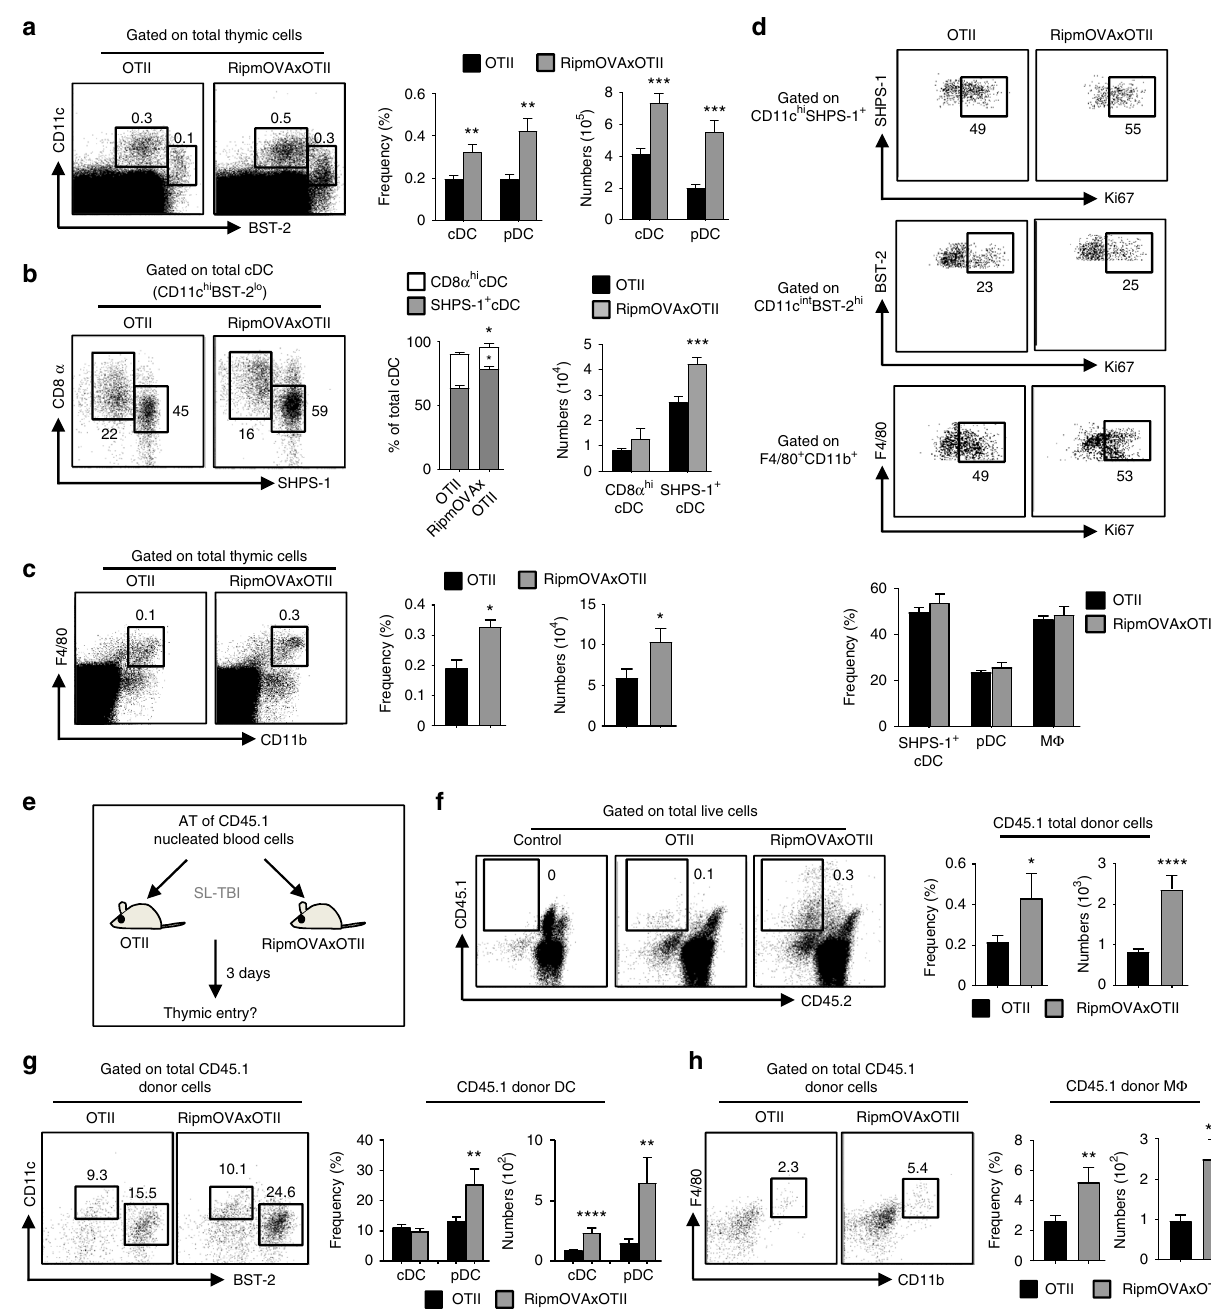
Fig. 1 Ag-speci fi c interactions between mTECs and CD4 + T cells increase the thymic entry of circulating DCs and macrophages. a – c Flow cytometry pro fi les, frequencies and numbers of cDCs (CD11c hi BST-2 lo ), pDCs (CD11c int BST-2 hi ) ( a ), resident cDCs (CD8 α hi SHPS-1 − ), migratory cDCs (CD8 α lo SHPS- 1 + ) ( b ) and macrophages (F4/80 + CD11b + ) ( c ) in the thymus from OTII- Rag2 − / − and RipmOVAxOTII- Rag2 − / − mice. Data are representative of three independent experiments ( n = 3 mice per group and per experiment). d Flow cytometry pro fi les and frequencies of proliferating Ki-67 + thymic DC subsets and macrophages. Data are representative of two independent experiments ( n = 3 mice per group and per experiment). e Experimental setup: nucleated blood cells from CD45.1 WT congenic mice were adoptively transferred into sublethally irradiated CD45.2 OTII- Rag2 − / − and RipmOVAxOTII- Rag2 − / − recipients. Three days after i.v . adoptive transfer (AT), the thymic entry of DCs and macrophages of CD45.1 donor origin was analysed. SL-TBI: sublethal total body irradiation. f – h Flow cytometry pro fi les, frequencies and numbers of CD45.1 total donor cells ( f ) as well as cDCs, pDCs ( g ) and macrophages ( h ) of CD45.1 donor origin in the thymus from OTII- Rag2 − / − and RipmOVAxOTII- Rag2 − / − recipients. Control: non-injected irradiated OTII- Rag2 − / − mice. Data are representative of three independent experiments ( n = 3 – 4 mice per group and per experiment). d , h M Φ : macrophage. Error bars show mean ± SEM, * p < 0.05, ** p < 0.01, *** p < 0.001, **** p < 0.0001 using unpaired Student ’ s t